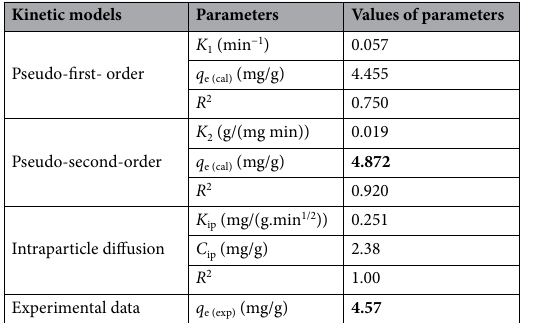
Table 3. The adsorption kinetic models and their parameters obtained from the fitting results. Significant are in value [bold].